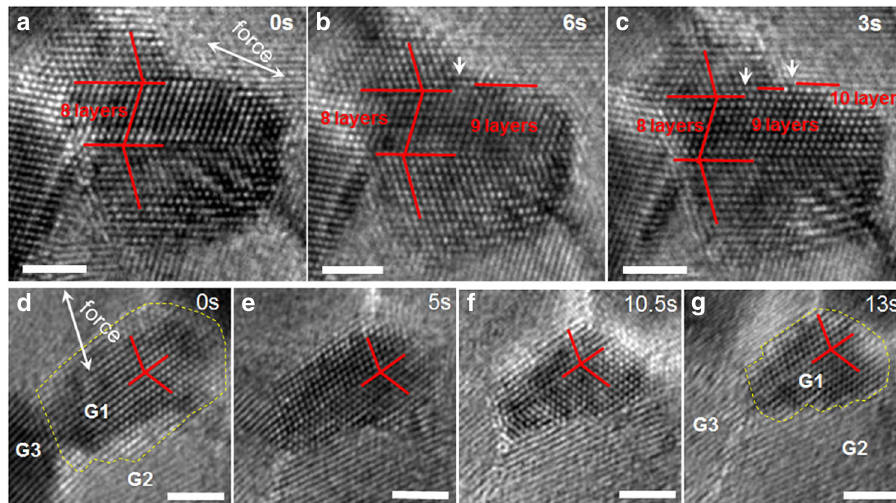
Fig. 4 Direct observation of switchover from partial dislocation to GB mediated plasticity. a HRTEM image taken when the loading is initially on the twinned grain, an 8-atomic-layer twin/matrix with atomically fl at TBs can be clearly seen. b With continued loading, a step resulted from partial dislocation in a TB (as marked). c With further straining, two steps resulting from partial dislocation in a TB with different positions can be seen. d – g Four HRTEM images captured during continuous tensile loading. The ∼ 4 × 6 nm sized grain shrinks into an ∼ 3 × 4.5 nm sized grain that results from GB migration. The scale bars are for 2